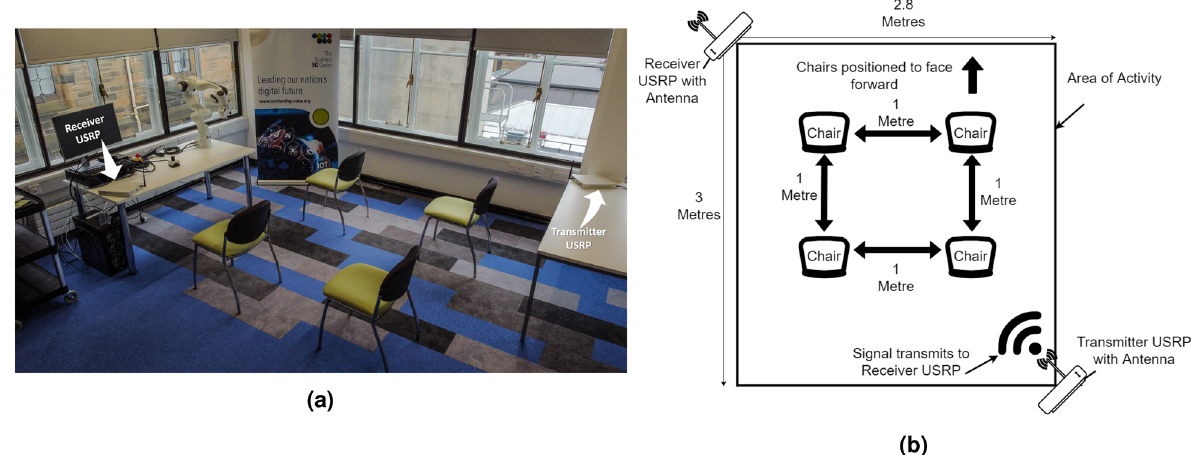
Figure 3. Experimental setup for capturing activities using 5G frequency.